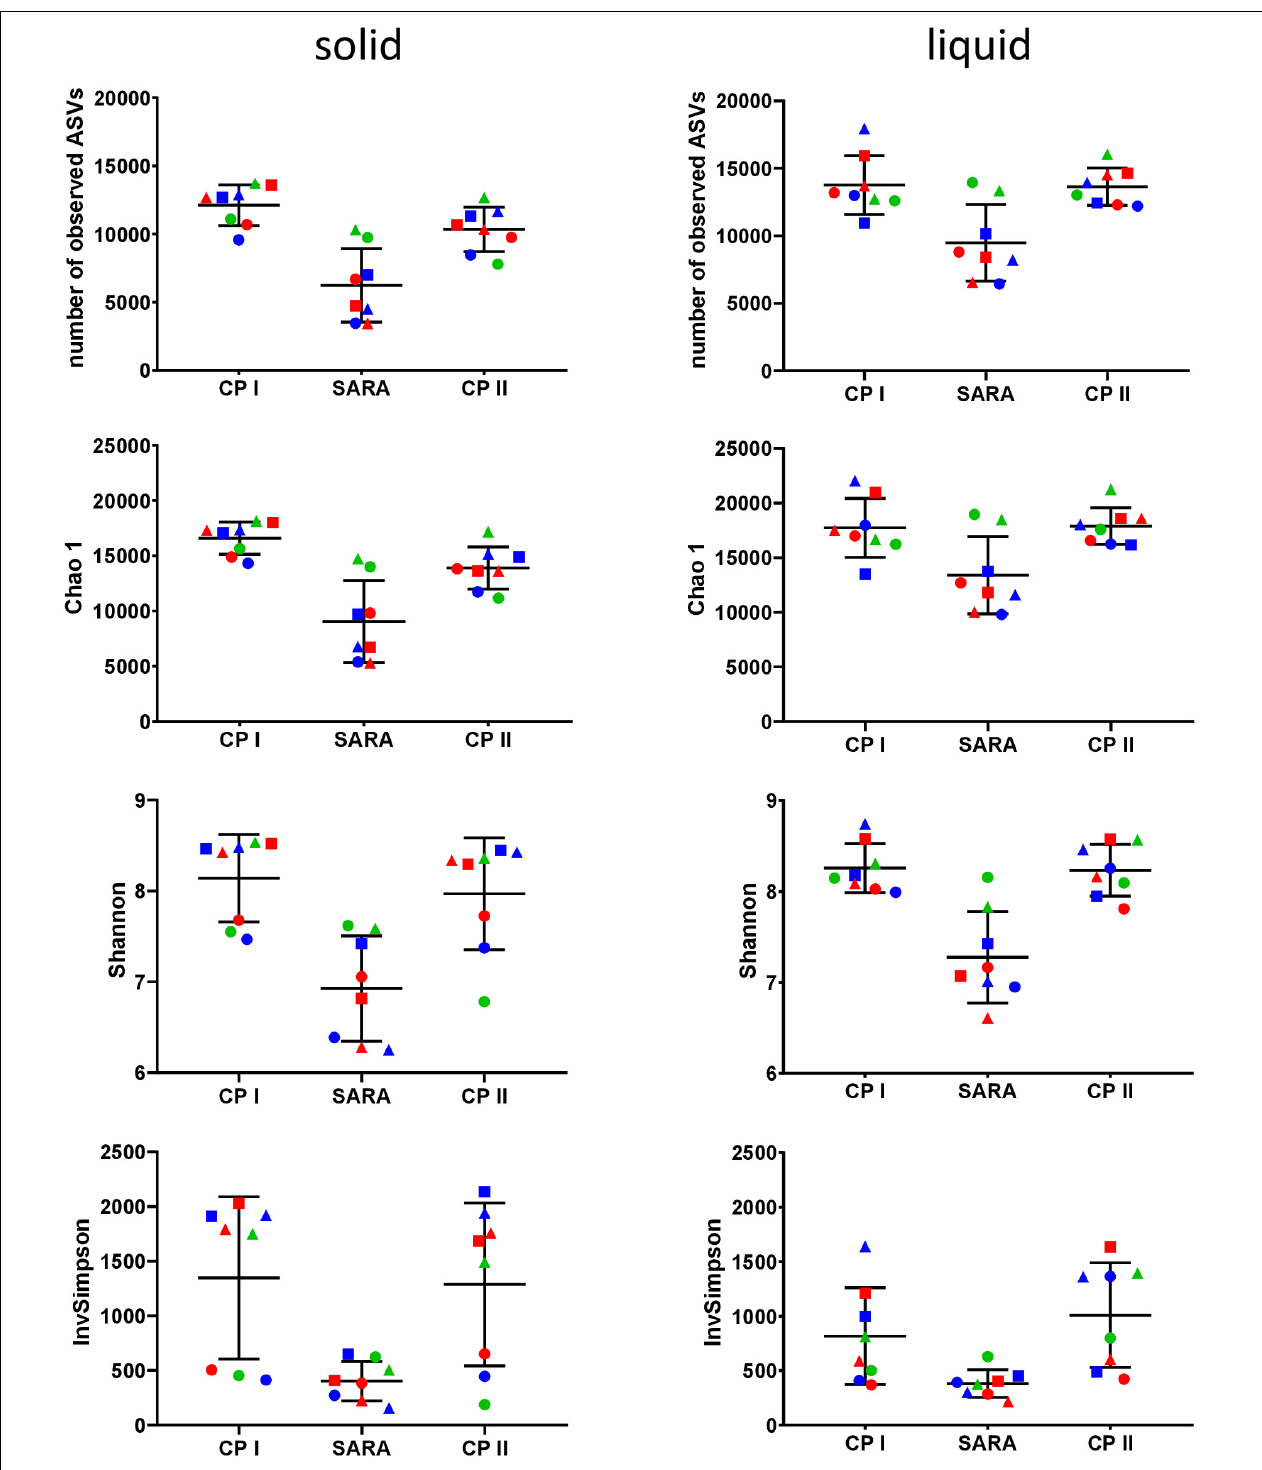
FIGURE 4 | Alpha diversity of the RUSITEC samples collected during control period I (CP I), subacute rumen acidosis period (SARA) and control period II (CP II). Samples from the solid (left) and liquid (right) phase of the fermenters were collected, pooled, and subjected to Illumina MiSeq amplicon sequencing (V4 region of the 16S rRNA gene). Alpha diversity measures were calculated. The treatment groups are marked according to the buffer type by colors (green = standard buffer, red = SARA I buffer, blue = SARA II buffer) and according to the concentrate ratio by shape (dots = 70% concentrate, triangles = changing ratio, squares = 30%